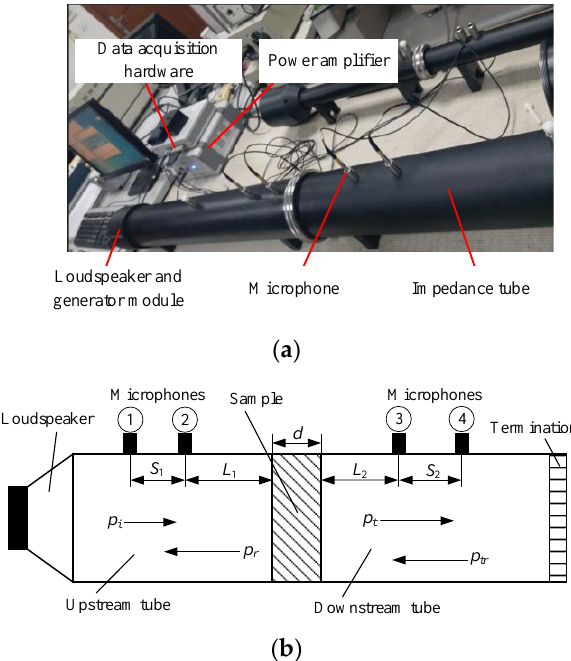
Figure 5. STL test system and test schematic of the impedance tube method. ( a ) STL test system; ( b ) test schematic of the impedance tube method. ( b ) test schematic of the impedance tube